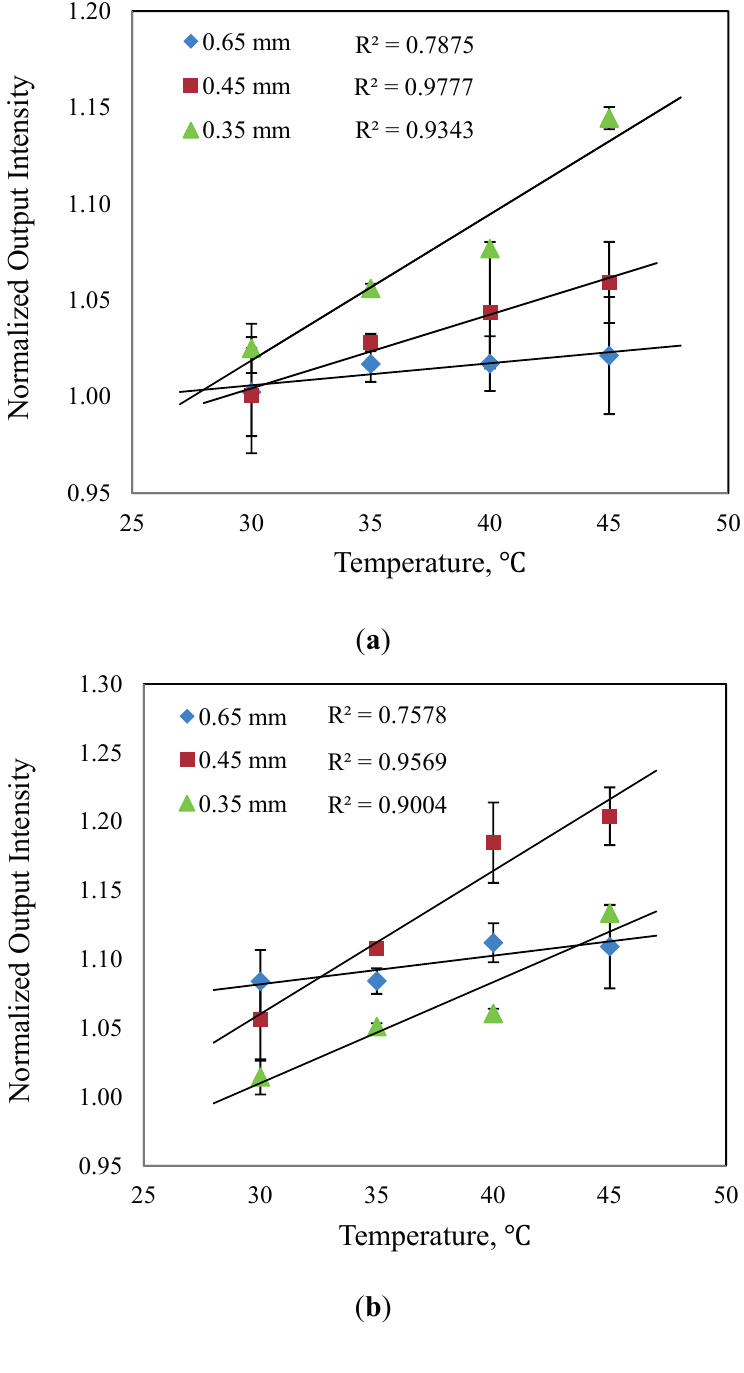
Figure 5. Responses of sensors toward temperature increment at ( a ) 50 ppm and ( b ) 100 ppm